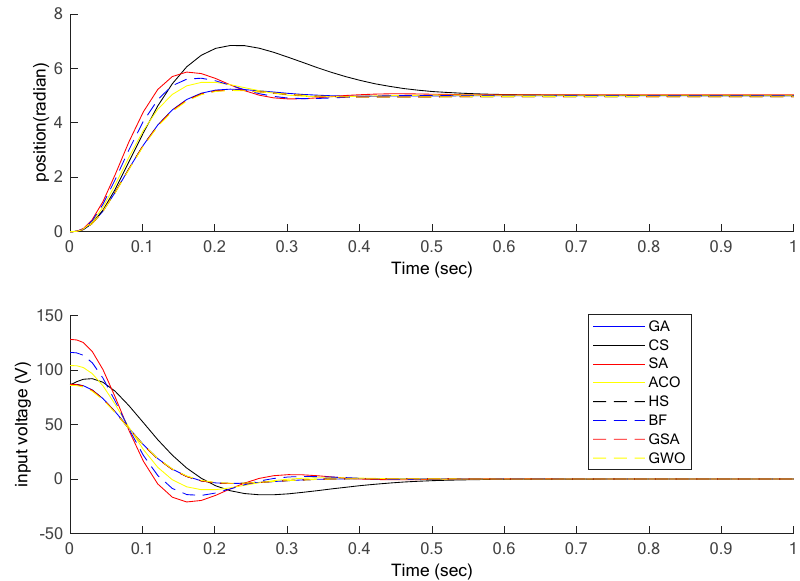
Figure 7. DC motor position control response with a PI controller.